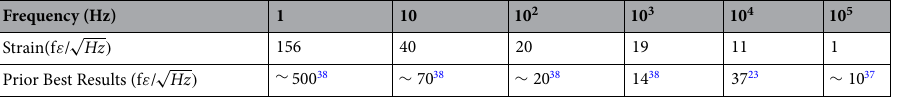
Table 1. Strain resolutions of the MZ-FP interferometer versus previous best results over six decades of